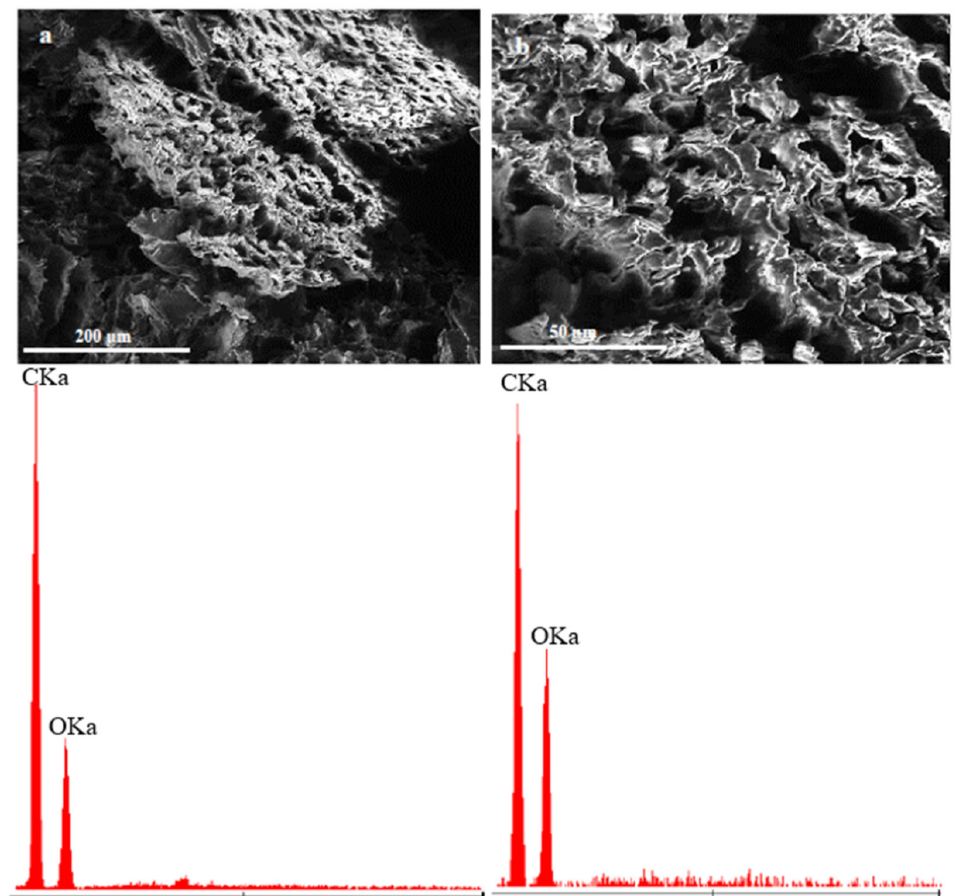
Figure 8. Wood flour before chemical treatment ( a )—magnification 350 × and after chemical treatment ( b )—magnification 1000 × and below adequate EDS